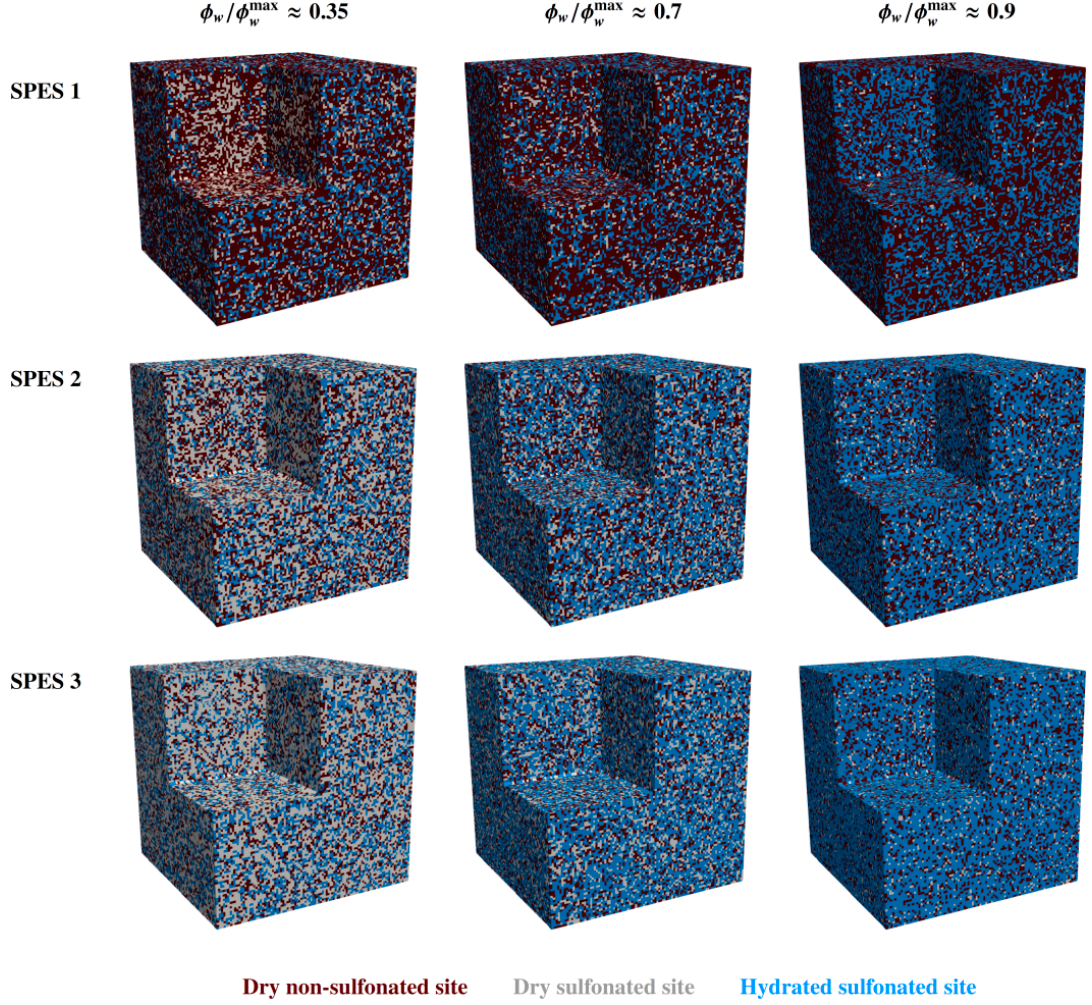
Figure A1. Virtually generated structures corresponding to the SPES membranes and three different relative volume fractions of hydrated sites, φ wr / φ max wr ( (cid:39) RH ) ≈ 0.35, 0.7, and 0.9. Blue sites correspond to hydrated sulfonated sites, gray sites to dry sulfonated sites, and brown sites to dry non-sulfonated sites.